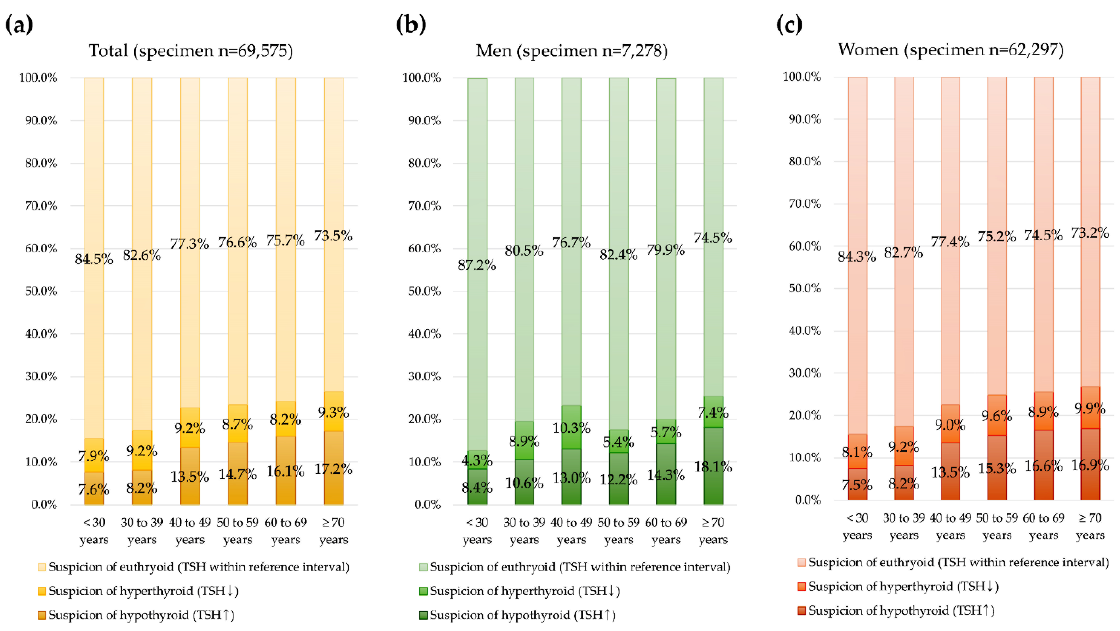
Figure 2. Specimen thyroid function test (TFT) results by age group. ( a ) For 69,575 overall specimens, ( b ) men, and ( c ) women.